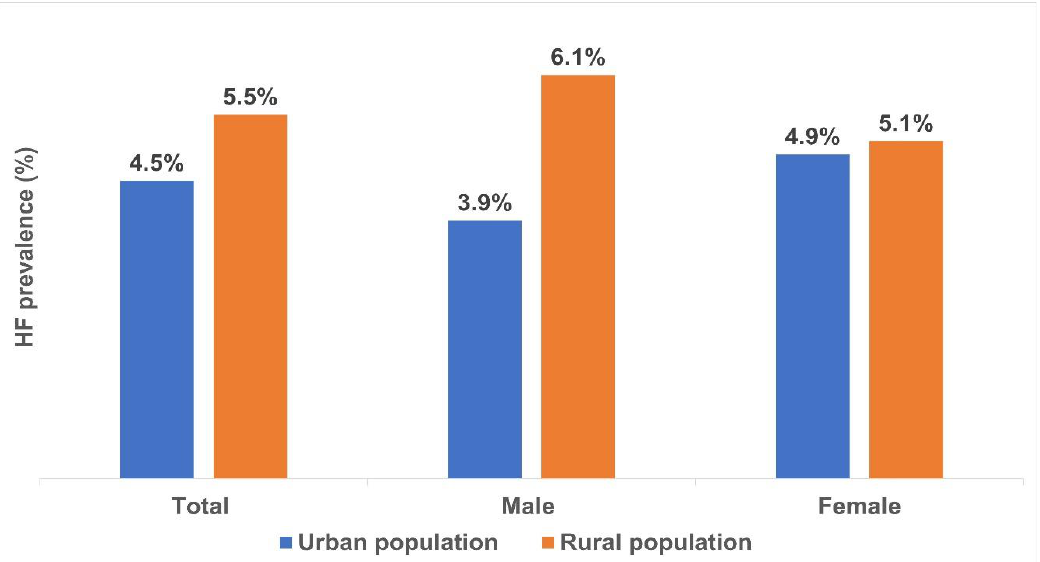
Figure 4. The prevalences of HF in the urban and rural populations. Note: The horizontal axis shows the total, urban, and rural population distribution. The vertical axis shows prevalence rate expressed as a percentage.